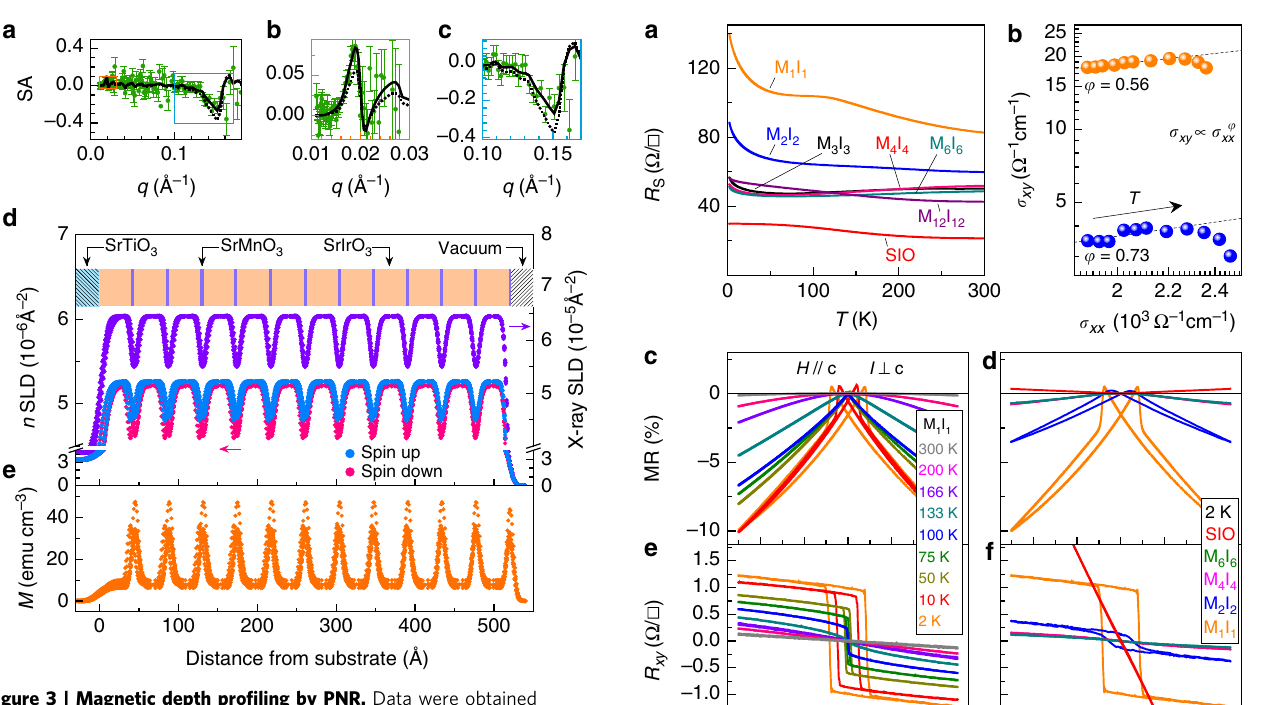
Figure 3 | Magnetic depth profiling by PNR. Data were obtained from a [(SrMnO 3 ) 1 /(SrIrO 3 ) 10 ] 12 superlattice on STO after a zero-field cooling at T ¼ 10K and H ¼ 11.5kOe with H > c . ( a ) The spin asymmetry (SA ¼ [R m (cid:2) R k ]/[R m þ R k ]), where solid (dotted) black lines represent models where the magnetism in the SIO layer is allowed to vary (forced to zero) for the fit. The orange and cyan rectangles represent the positions near the critical angle and first superlattice Bragg reflection shown in b and c , respectively. ( d ) Depth profile of X-ray (purple) and neutron (blue and pink) scattering length densities, where a schematic drawing of the sample geometry is shown above the data. ( e ) Magnetic depth profile obtained with fit parameters of M Mn ¼ 85emucm (cid:2) 3 (0.54 m B /Mn) and M Ir ¼ 9emucm (cid:2) 3 (0.06 m B